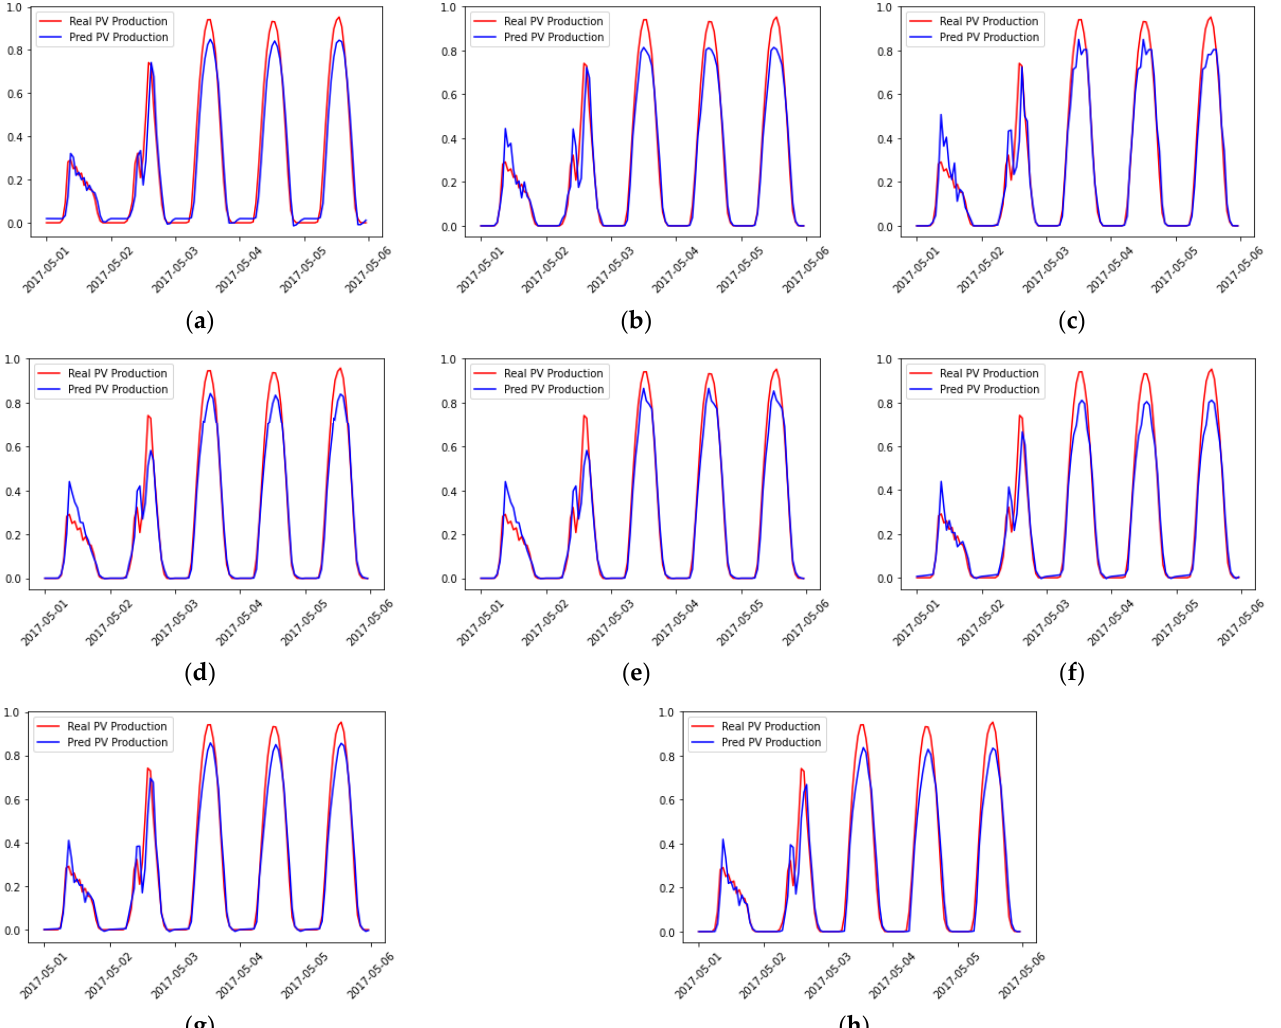
Figure 10. Hourly prediction of the first five days of May 2017 for ( a ) LR, ( b ) kNN, ( c ) DT, ( d ) XGB, ( e ) LGBM, ( f ) MLP, ( g ) ENN and ( h ) LSTM.